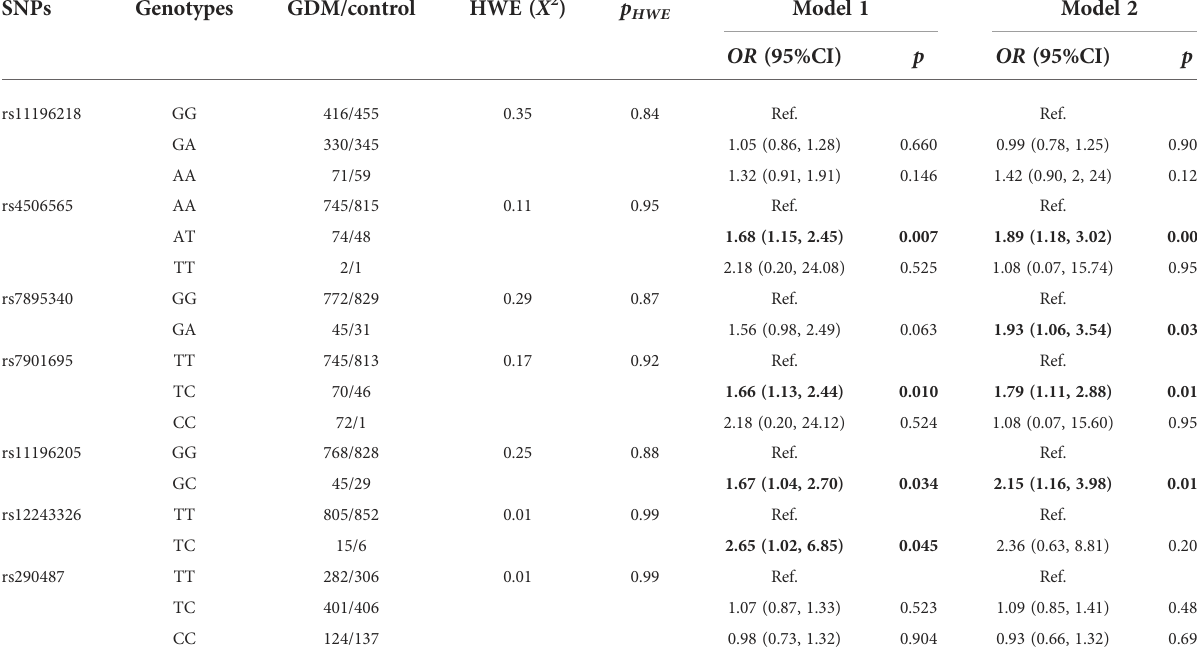
TABLE 2 Association between TCF7L2 gene SNPs and GDM risk. SNPs